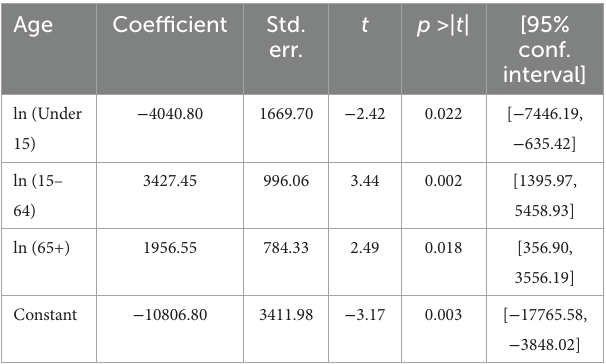
TABLE 1 Regressing COVID on ln (age).